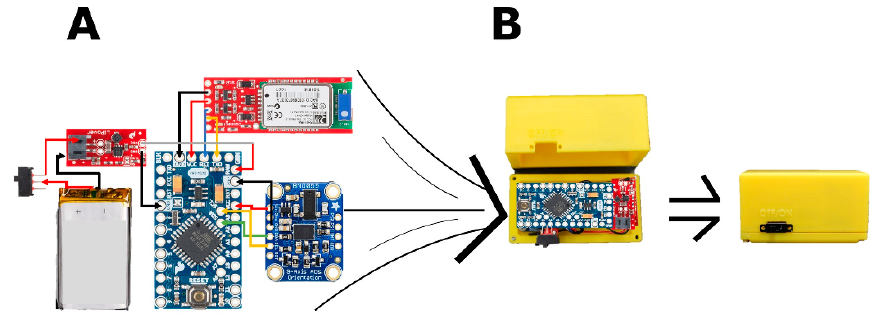
Figure 1. ( A ) The wireless inertial measurement unit-based system (WIbS) consisted of two of the following: an Arduino Pro Mini microcontroller (center), an inertial measurement unit (bottom right), a Bluetooth radio (top right), a lithium-ion battery, and a boost converter (left of the microcontroller). ( B ) An enclosure was manufactured for each sensor module to manage wires, improve ergonomics, and fixate the inertial measurement unit.